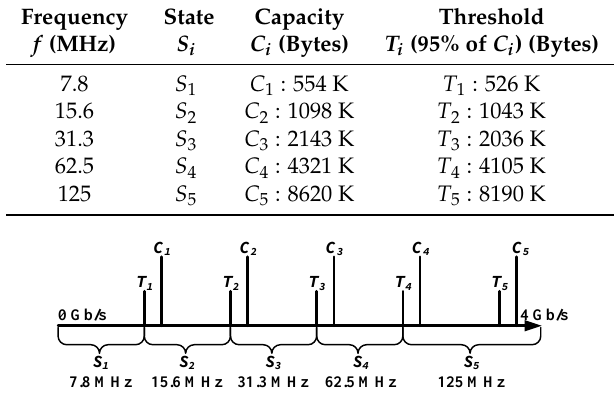
Table 1. Frequency, capacity and threshold mapping table for the single-threshold policy (STP).